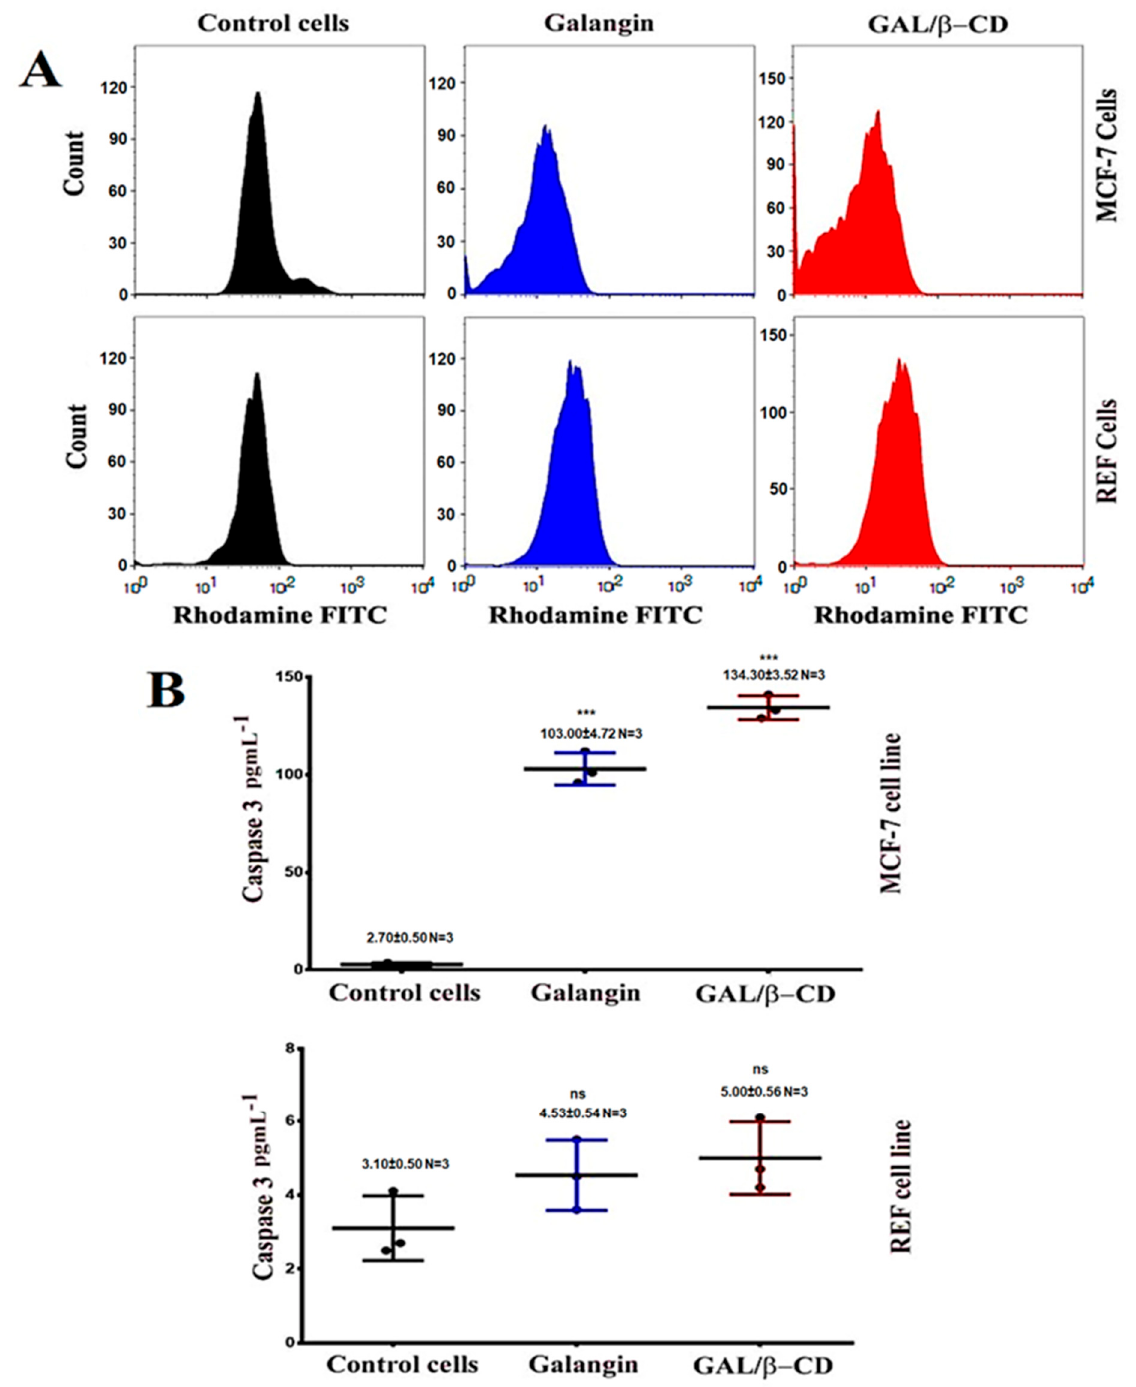
Figure 11. ( A ) Flow cytometry data of MCF-7 and REF cells treated as indicated. Rhodamine stain was used to investigate loss of mitochondrial activity. ( B ) Caspase-3 protein induction in MCF-7 and REF cells. *** p ≤ 0.001. ns, non-significant. N = 3, three replicates.